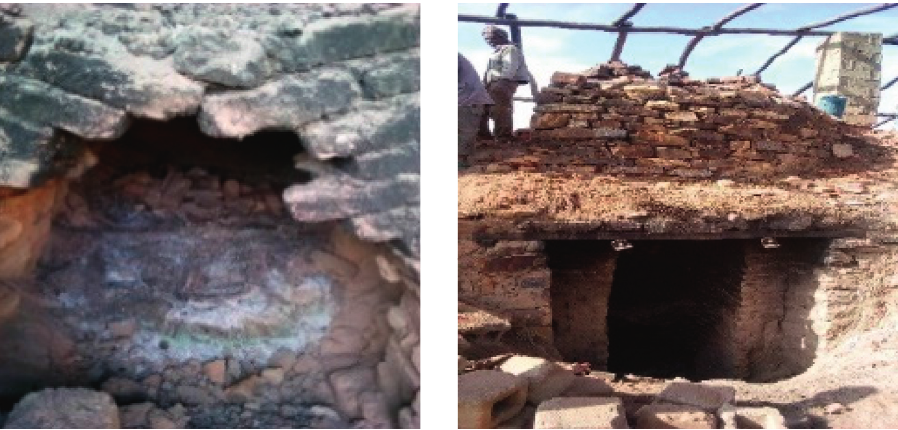
Figure 6: Burning process of brick.